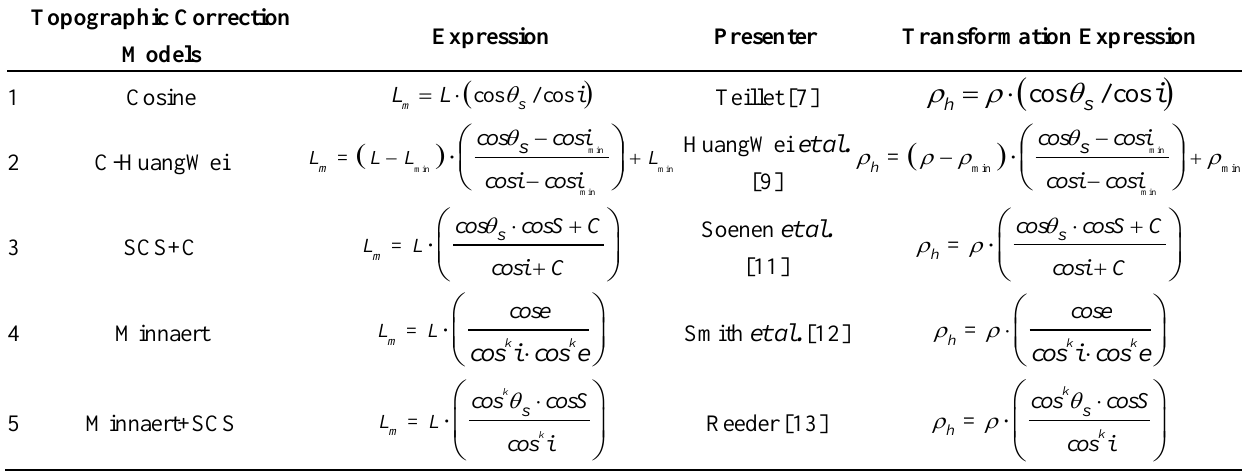
Table 2. The topographic correction models used in this